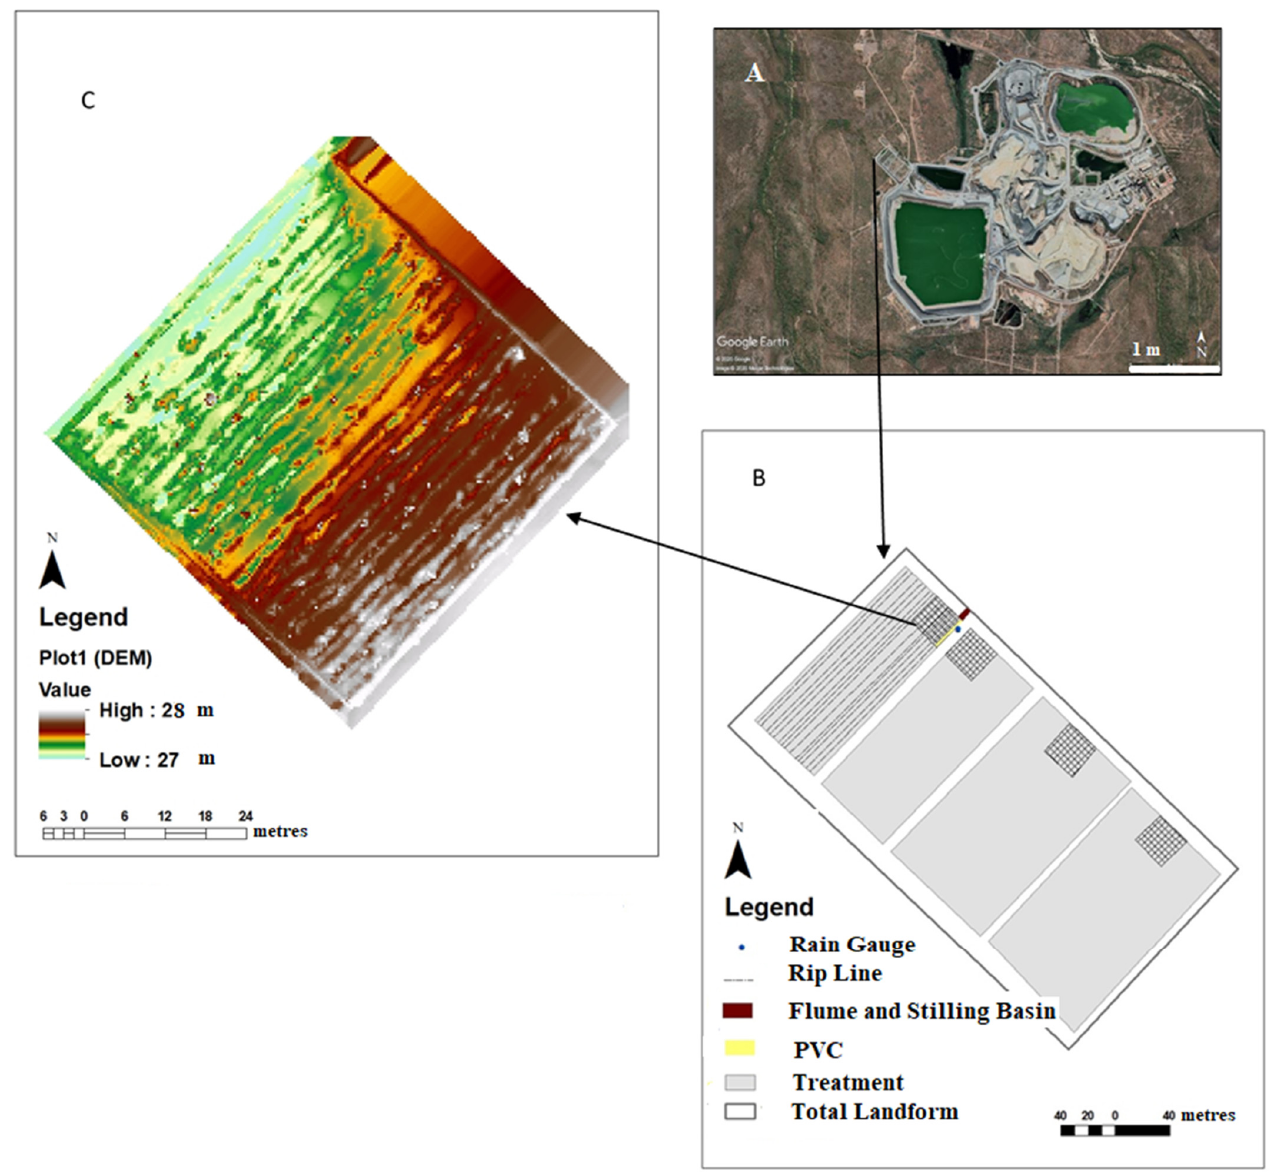
Figure 1. Location plan and plot topography: ( A ) the location of the landform within the Ranger Uranium Mine, ( B ) the location of plot 1 within the landform and ( C ) the digital elevation model (DEM) of plot 1. PVC: polyvinyl chloride.